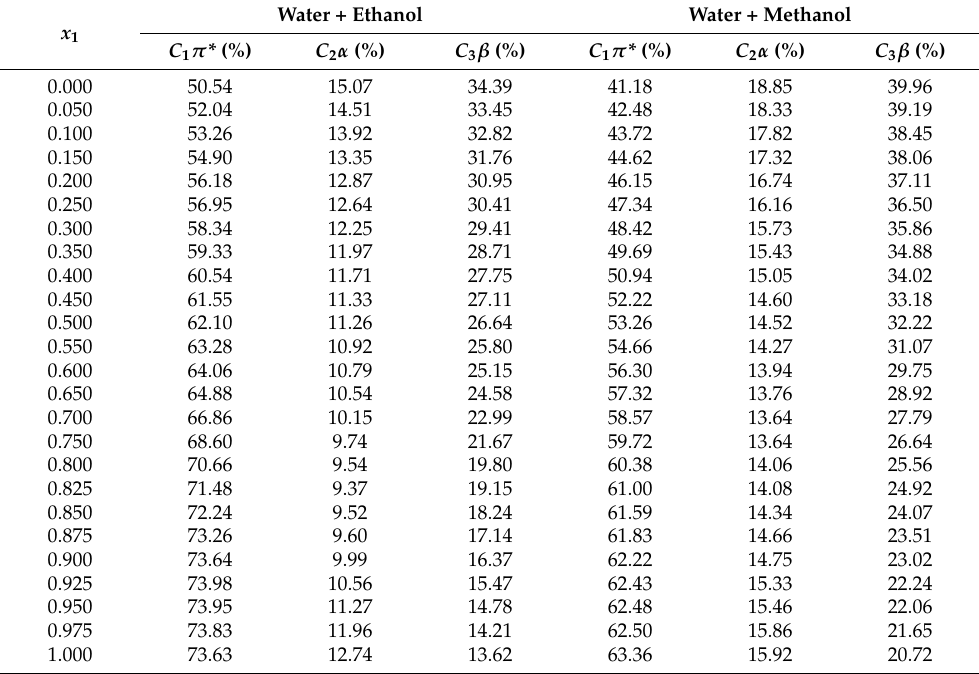
Based on relation (1), the values of the regression coefficients from Table 3, and the binary solvent mixture parameters from Tables 1 and 2, the contribution (expressed in percent) of each type of intermolecular interaction to the spectral shift can be estimated. The results of computations are listed in Tables 4 and 5. Table 4. Contribution of each type of interaction in solutions of 4-tolyl-1,2,4-triazol-1-ium phenacylid (TTPY) in the binary hydroxylic solvents mixtures.